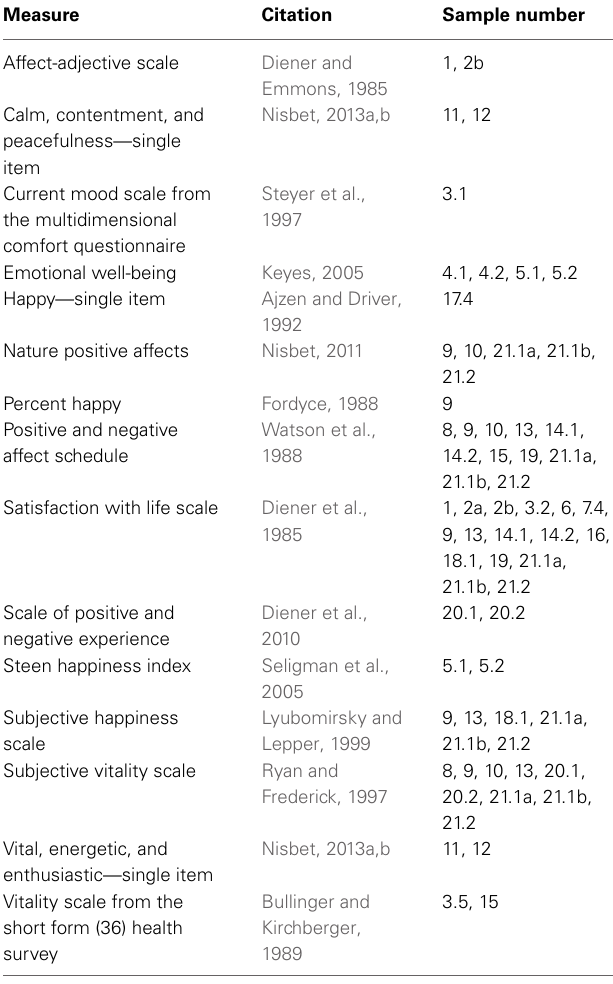
Table 2 | Happiness measures included in